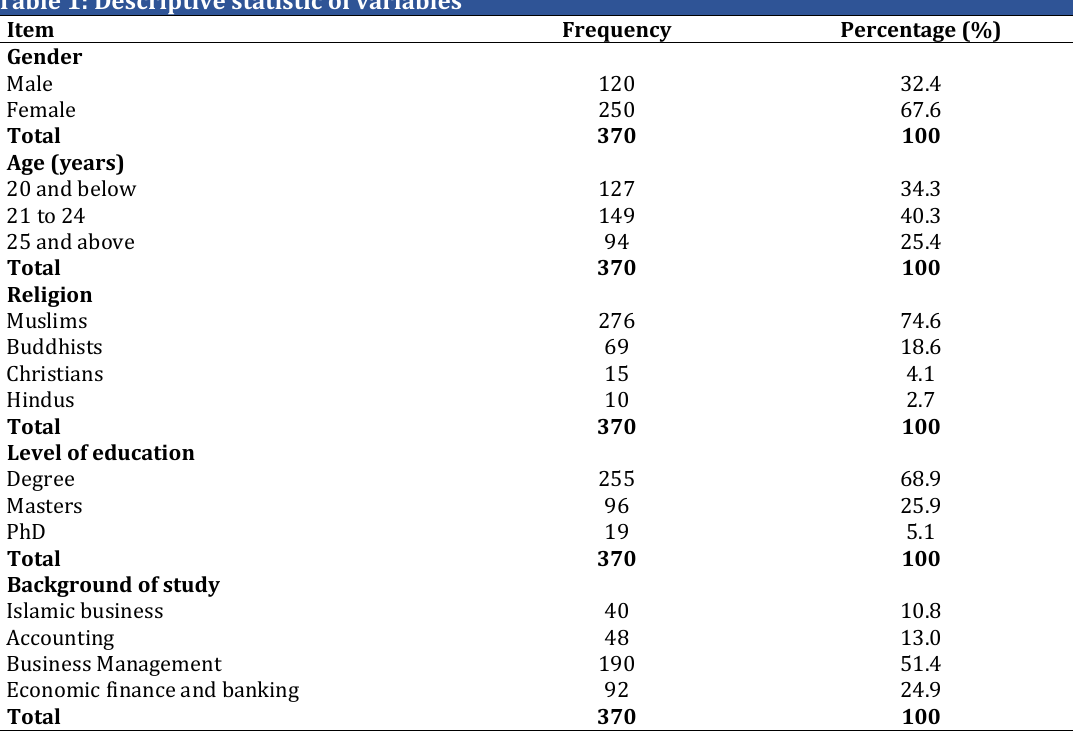
Table 1: Descriptive statistic of